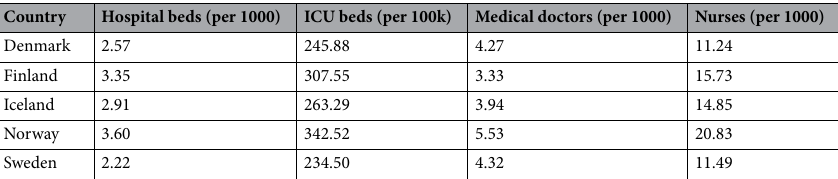
Table 4. The number of hospital and ICU beds, doctors and nurses in the five Nordic countries. Source: https:// tradi ngeco nomics.